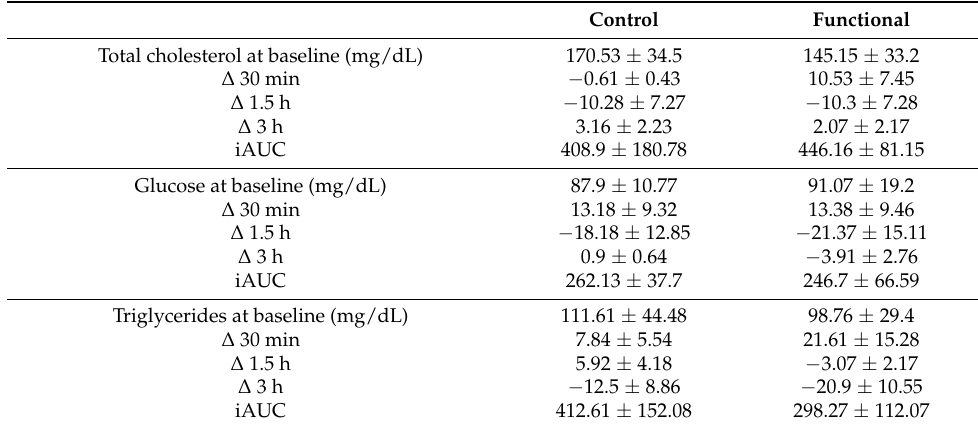
Figure 6. ( a ) Incremental changes in postprandial total cholesterol concentration. ( b ) Incremental changes in postprandial HDL-cholesterol concentration. ( c ) Incremental changes in postprandial LDL-cholesterol concentration. ( d ) Incremental changes in postprandial serum glucose concentration. ( e ) Incremental changes in postprandial uric acid concentration. Table 3 summarizes postprandial responses of serum lipids, glucose, aggregation, and plasma TAC, following a high-carbohydrate and fat meal, containing a novel miso-type or a control sauce. Table 3. Postprandial responses of serum lipids, glucose, aggregation, and plasma TAC, following a high-carbohydrate and fat meal, containing a novel miso-type or a control